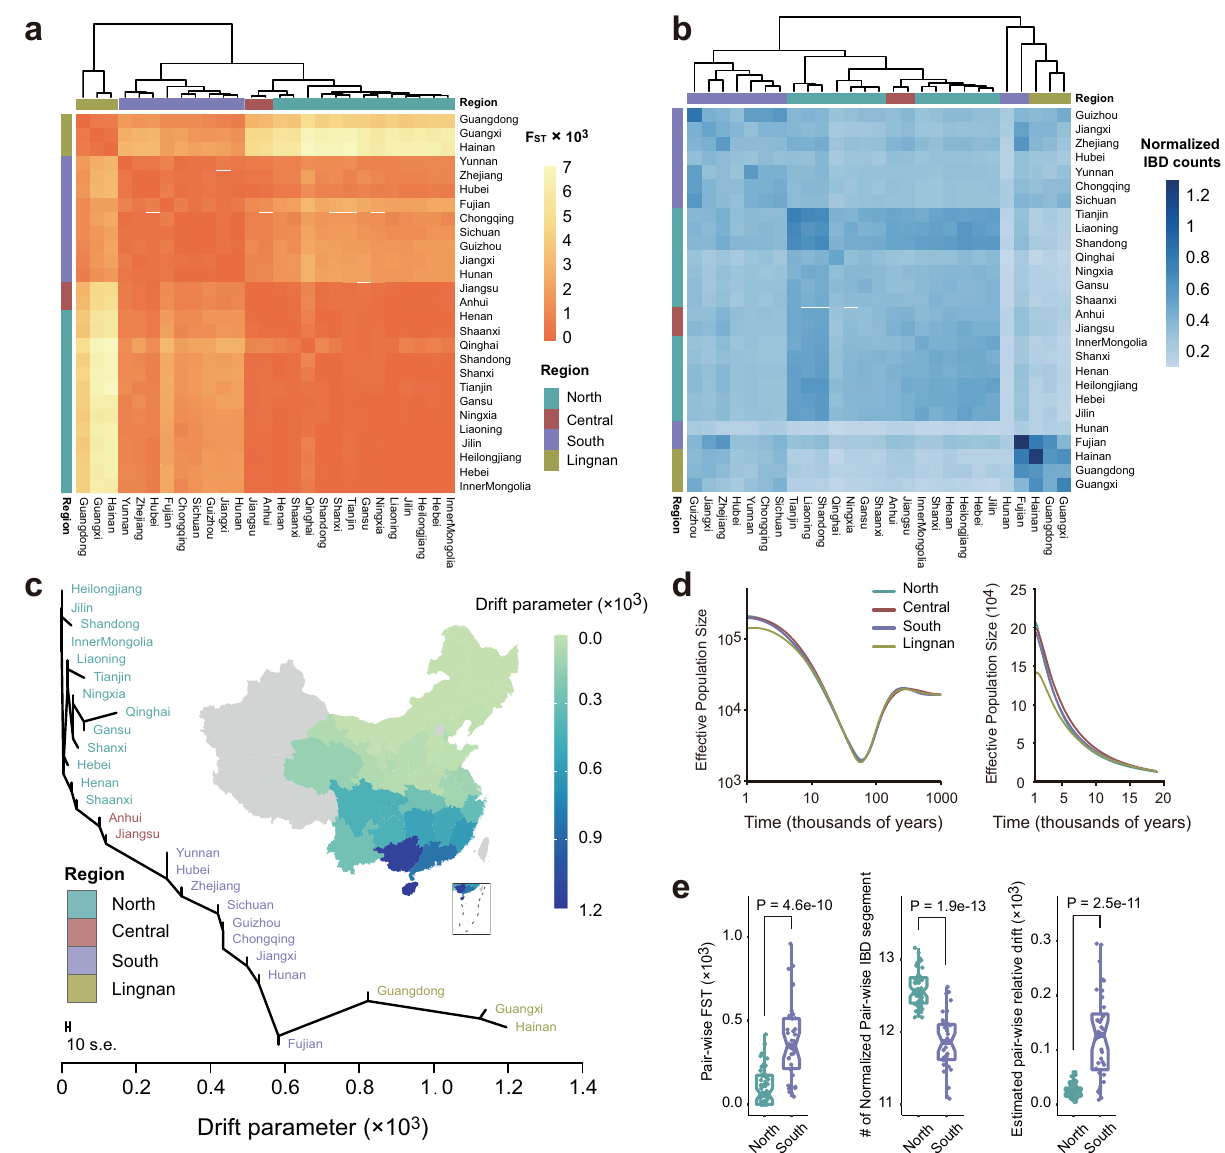
Fig. 5 F ST , IBD, genetic drift, and effective population size of the Han Chinese populations. a A heatmap of pairwise F ST between any two of the 27 administrative divisions in China. The bars on the top and left show the classi fi cation of administrative divisions in the four regions. b A heatmap of pairwise IBD segments count between administrative divisions in China. The number of IBD segments is normalized by the sample size of each province. c A maximum-likelihood tree of the Han Chinese in 27 administrative divisions. The plot is rooted in the northernmost province, and the x -axis represents estimated genetic drift. All administrative divisions in the tree are colored by different regions. d Dynamics of effective population sizes of the Han Chinese in four regions. The x -axis means the thousands of years before present. The left panel shows the results on a log-log scale from 1 million to 1000 years ago and the right panel shows the results on a linear scale over the past 20,000 years. e Wilcoxon rank-sum test (two-sided) results for the F ST (left panel), normalized IBD segments (middle panel), and relative genetic drift (right panel) between pairwise Northern provinces and pairwise Southern provinces. The quartile for corresponding differences between pairwise provinces was plotted. A total of 12 Northern and 9 Southern provinces were included here. Source data are provided as a Source Data fi